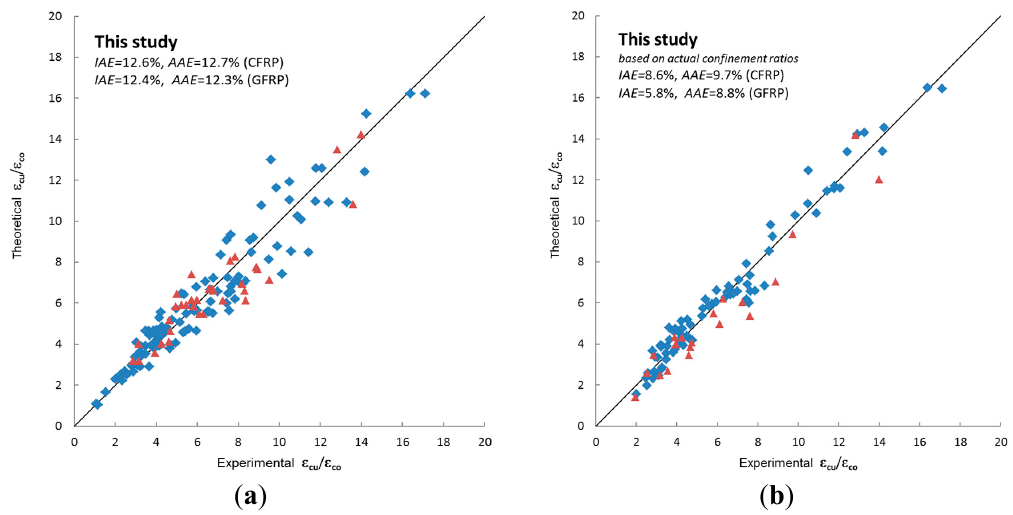
Figure 4. The assessment performance of proposed strain models for ( a ) predicted confinement ratio f l / f co based on ultimate fiber strain ε fu from Model Ib, II, III, V,VI; ( b ) actual confinement ratio f l,a / f co based on ε h,u from Model IV and VII, ♦ for CFRP sheets, ▲ for GFRP sheets.